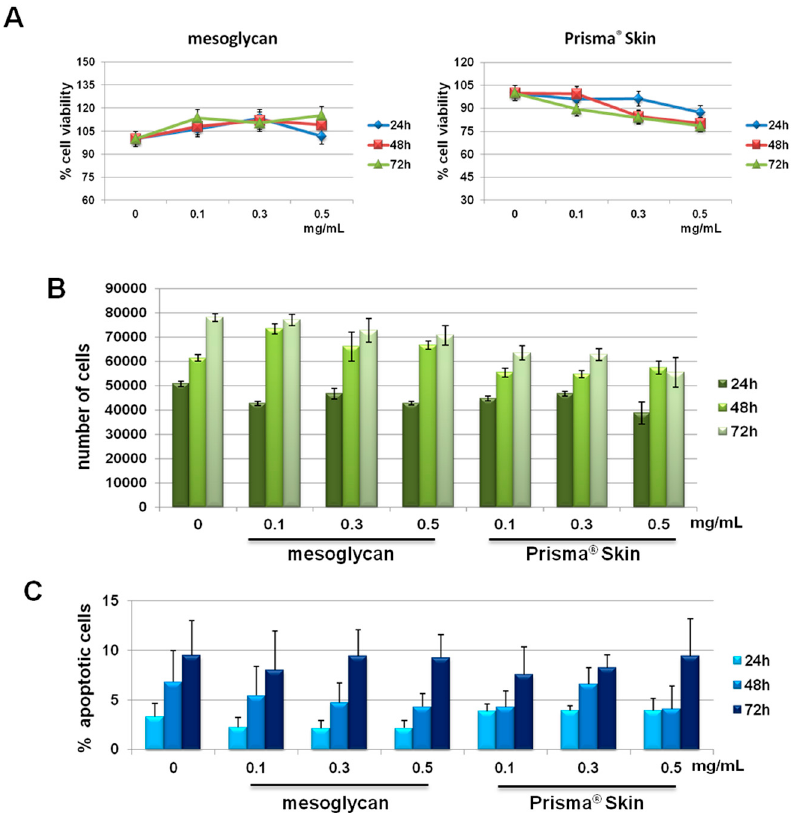
Figure 1. ( A ) MTT (3-(4,5-Dimethylthiazol-2-yl)-2,5-Diphenyltetrazolium Bromide) assay on HUVEC cells evaluating cell viability. Absorbance relative to controls was used to determine the percentage of cells treated with sodium mesoglycan and Prisma ® Skin 0.1, 0.3 and 0.5 mg/mL at 24, 48 and 72 h. The values reported in the graphs are the mean ± S.E.M. from five independent experiments performed in triplicates, results appeared not significant (ns, p > 0.05); ( B ) Hemocytometer counting of HUVEC cells treated or not with mesoglycan and Prisma ® Skin. The data are representative of five experiments with similar results; ( C ) Analysis of apoptotic cells by cytofluorimetric assay of the effect of 0.1, 0.3 and 0.5 mg/mL of mesoglycan and Prisma ® Skin at 24, 48 and 72 h. The data are the mean of five experiments with similar results (ns, p > 0.05, based on Student’s t-test, assuming a two-tailed distribution and unequal variance).